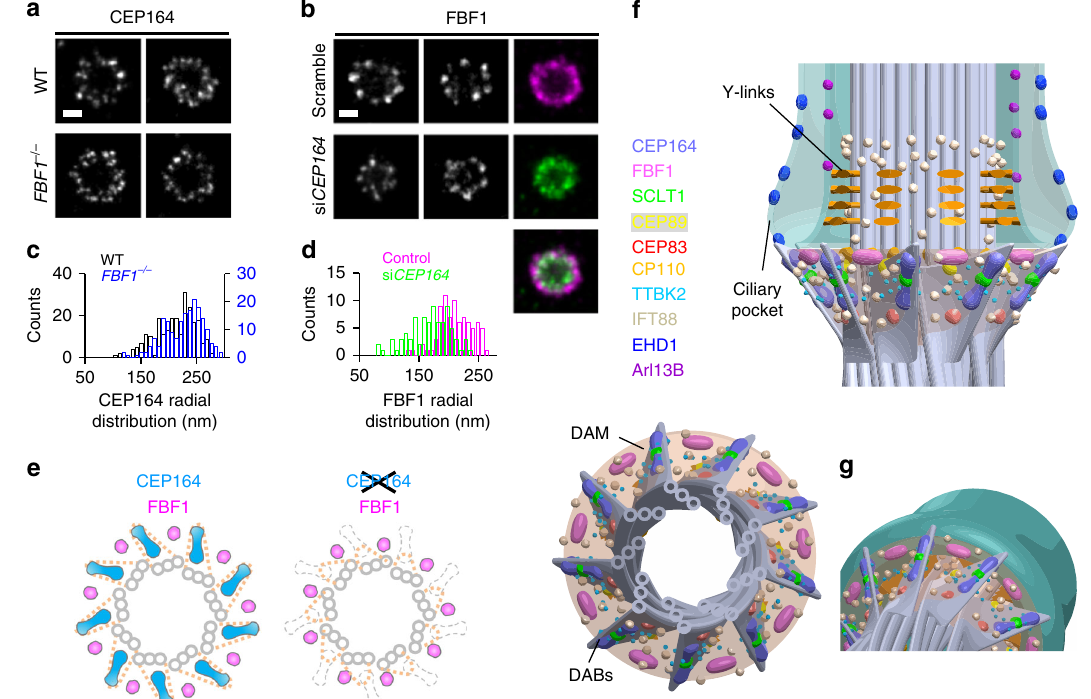
Fig. 6 DAB components mediating the structural arrangement of the DAM. a , b Axial view dSTORM images reveal the distribution of a CEP164 and b FBF1 at the mother centrioles upon CRISPR/Cas9 FBF1 knockout and CEP164 siRNA silencing, respectively. It is noteworthy that the FBF1 ring formed upon CEP164 knockdown becomes smaller than that of controlled cells ( b , right panel). c , d Statistical analysis of the radial distribution of CEP164 and FBF1 upon perturbation. The size of CEP164 in FBF1 − / − cells is comparable to that in WT cells c , whereas the size of FBF1 is reduced upon CEP164 knockdown d . e Model showing that the arrangement of FBF1 is no longer maintained at the outer region of the DAM in the absence of CEP164. f Three-dimensional model based on all axial and lateral super-resolution images illustrating the molecular architecture on the framework of DABs, DAM, axoneme, and ciliary membrane. g Close-up view of the DAP region, suggesting that FBF1 potentially interfaces the ciliary membrane and the DAM. Bars = 200